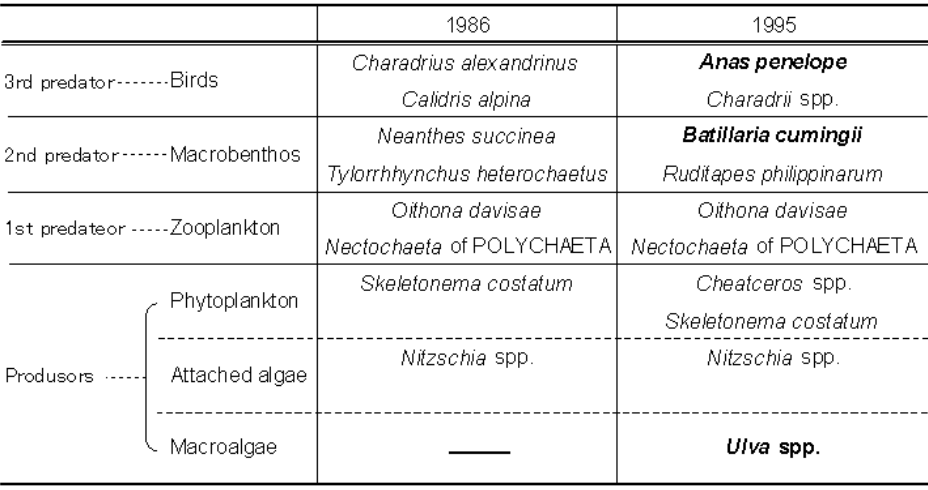
Dynamics of Biota in Yatsu Tidal